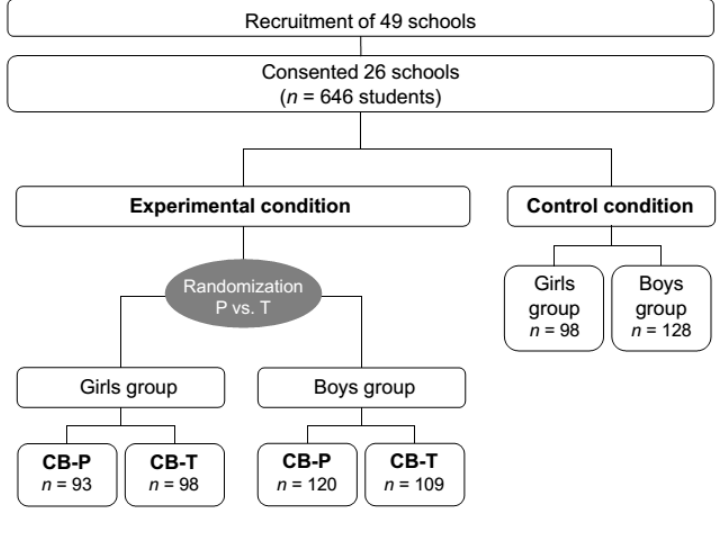
Figure 1. Flowchart. CB-P = psychologist-led intervention condition. CB-T = teacher-led intervention